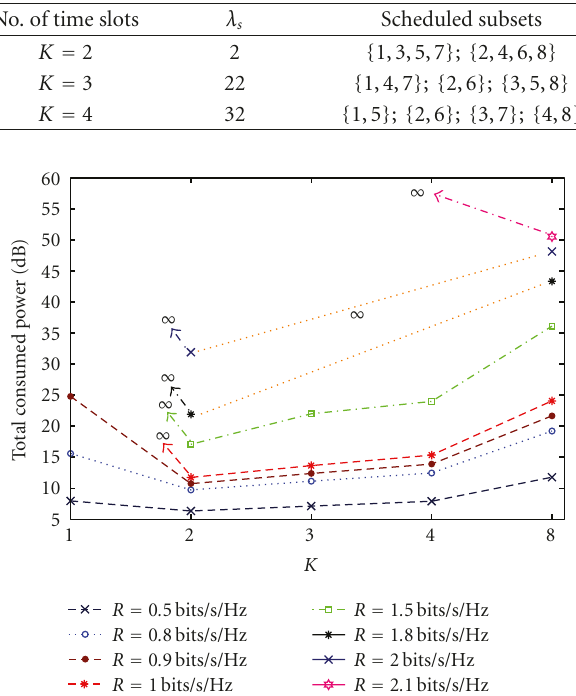
Figure 3: Total transmission power (dB) consumed by the ring net- work of eight links versus K , where ∞ indicates that there is no fi- nite power allocation to satisfy the uniform link data rate r l = R in bits/s/Hz. Shown in this figure, R ≥ 1 is infeasible for K = 1, R ≥ 1 . 8 infeasible for K = 3,4, and R ≥ 2 . 1 infeasible for K = 2. The transition from a feasible data rate with moderate power allo- cations to an infeasible data rate with infinite power allocations is very sharp for each of K <